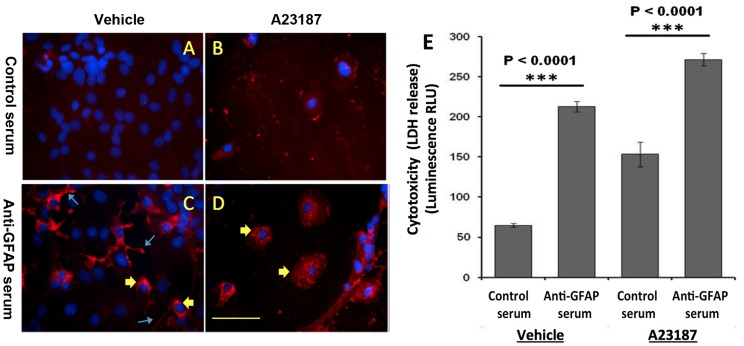
Effects of human TBI serum anti-GFAP autoantibody primary rat glial cells.(A–E) Primary rat glia cells were plated on cover slip and cell chamber and incubated in media that included 1/50 serum collected from either human TBI serum with no detectable anti-GFAP autoantibody (Control serum) (A,B) or human TBI serum with strong anti-GFAP autoantibody (C,D). Cells were treated with either vehicle (DMSO) (A,C) or 20 μM A23187 (calcium ionophore) (B,D) for 24 hours, After the 24 h incubation, media was removed and the cells were fixed, stained with Hoechst and developed with anti-human IgG secondary antibody, Scale bars 10 microns. Yellow arrowheads indicate glial cell body staining with IgG while blue arrows indicate glial processes staining. (E) To test of effects of glial health, we used pooled 4 control samples and 9 TBI samples with strong autoantibody response. Cells were co-treated with either vehicle (DMSO) or 20 μM A23187 for 24 hours. Cell death (by LDH release) was measured using CytoTox-Glo™ Cytotoxicity Assay. Luminescence was read and media from each of the different conditions was used to measure the background, which was subtracted from the individual readings. * (P<0.0001) Represents significant increase of glial death in cells treated with TBI serum as compared to cells treated with control serum (control or with A23187, respectively), using an ANOVA analysis with Bonferroni multiple comparisons.